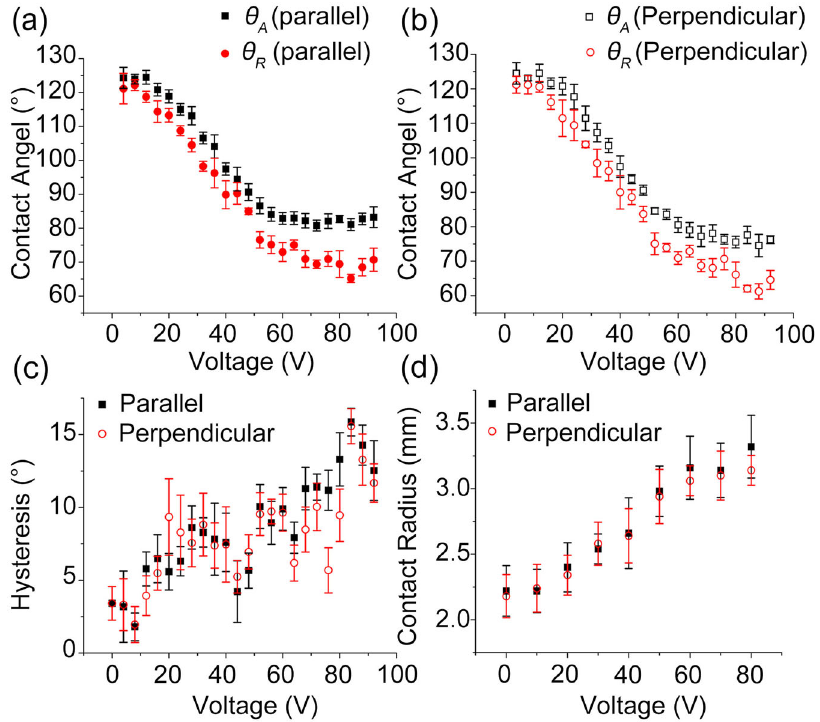
Fig. 2 Effect of the electric voltage on apparent contact angles of 40 μ L droplets. a Advancing and receding contact angle parallel to the electrodes. b Advancing and receding contact angle perpendicular to the electrodes. c Contact angle hysteresis in parallel and perpendicular directions. d Spreading radius in parallel and perpendicular directions. Experimental data are averaged over fi ve independent measurements, the error bars indicate the standard